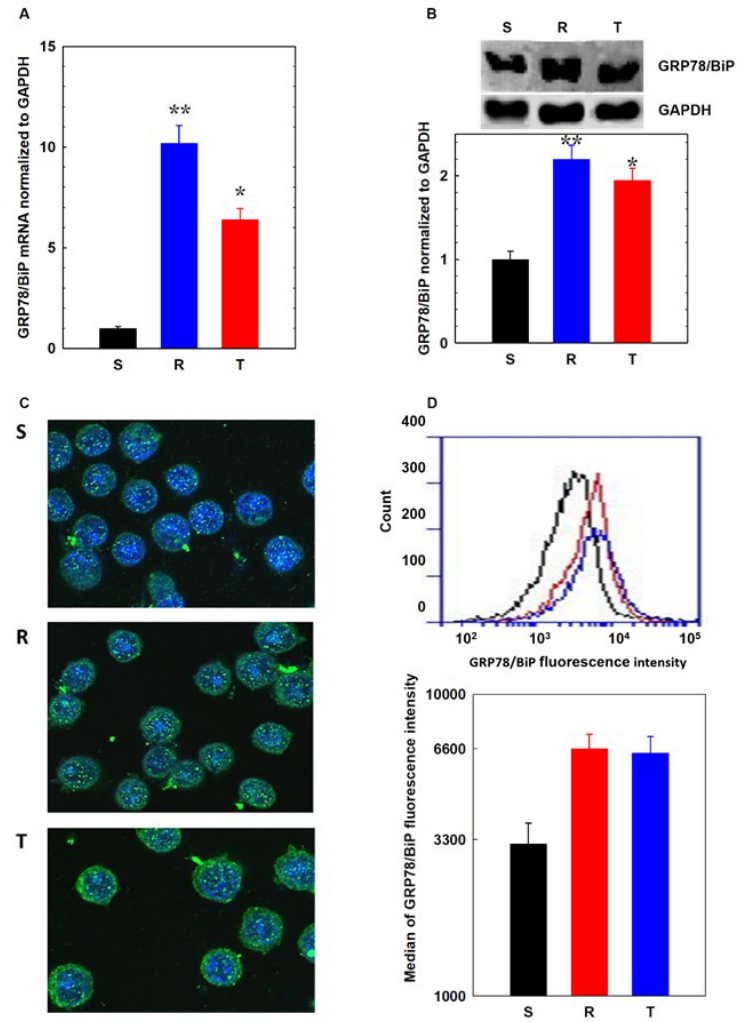
Figure 5. Detection of GRP78/BiP expression in S, R, and T cells: ( A ) Estimation of GRP78/BiP mRNA by qRT-PCR; data represent the mean ± S.E.M. of three experiments. Data differ from values obtained for S at the levels * p < 0.02.; ** p < 0.002. ( B ) Western blot detection of GRP78/BiP and its quantification: data are expressed as the mean ± S.E.M. of three independent experiments. Data differ from values obtained for S at the levels * p < 0.02.; ** p < 0.002. ( C ) Immunocytometric visualization of GRP78/BiP in S, R, and T cells